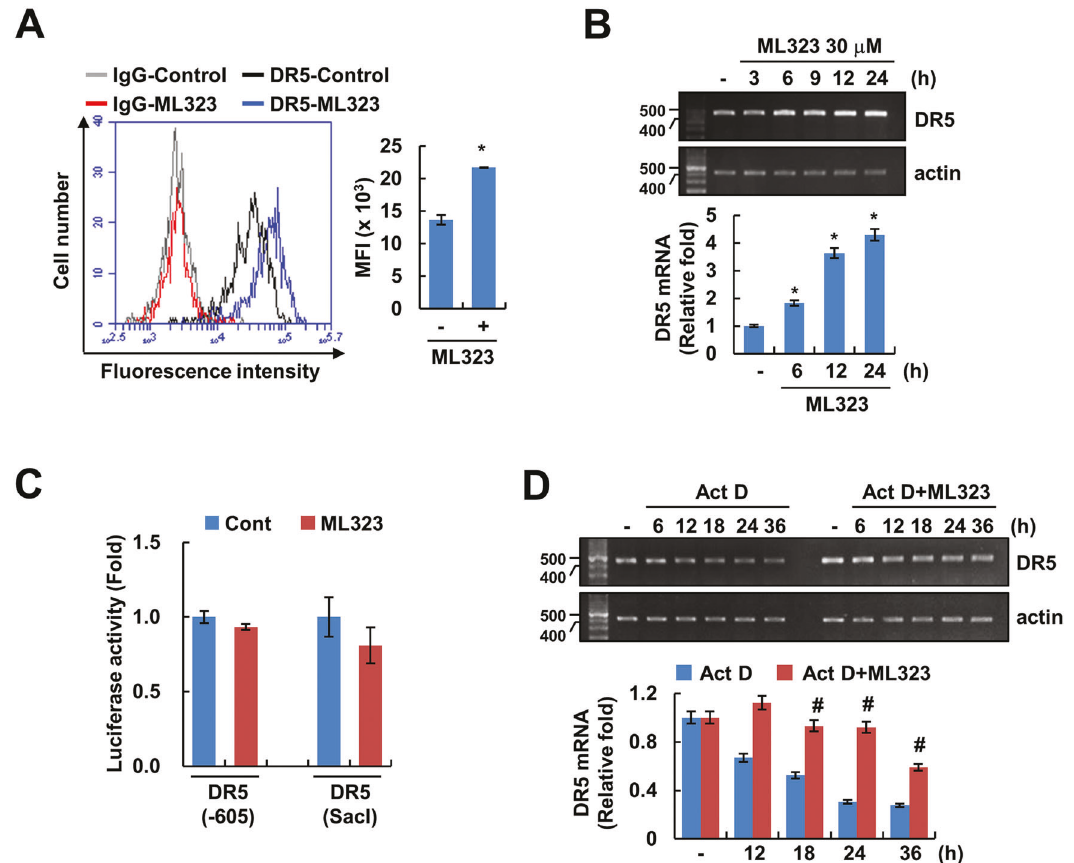
Fig. 3 ML323 upregulates DR5 expression at the post-transcription level. A Investigation of DR5 surface expression in Caki-1 cells treated to 30 μ M ML323 for 12 h. B Investigation of DR5 mRNA expression using RT-PCR and qPCR in Caki-1 cells treated to 30 μ M ML323 for the indicated time periods. C Caki-1 cells were transiently transfected with DR5 ( − 605) or DR5 (SacI) promoter plasmids, treated with 30 μ M ML323 for 12 h, and analyzed by luciferase activity assay. D Caki-1 cells were pretreated with 2 μ g/mL actinomycin D (Act D) for 30 min and then treated with 30 μ M ML323 for the indicated time periods. DR5 mRNA expression were analyzed using RT-PCR and qPCR. Values in the graphs ( A – D ) represent the mean ± SD of three independent experiments. * P < 0.01 compared to the control. # P < 0.01 compared to Act tissues. The expression levels of USP1 was higher in tumor tissues Mouse xenograft model Male BALB nude mice (Bagg and albino) were purchased from JA Bio, Inc. than in non-tumor tissues (Fig. 1A). To determine the overall (Suwon, Korea). HCT116 cells were subcutaneously injected into the fl ank survival rate, prognostic relevance of USP1 was analyzed by of each mouse. Mice were randomized into two groups (six mice per correlating baseline USP1 expression with the overall survival of group) for treatment with either vehicle [2% dimethyl sulfoxide (DMSO)/ RCC. Patients with high-expression levels of USP1 had shorter PBS] or 10 mg/kg ML323 three times a week, an intraperitoneal injection. overall survival time than those with low expression levels in TCGA Tumor size was calculated using the formula [(length × width 2 )/2]. To dataset ( P = 0.00388) and TARGET dataset ( P = 0.043) (Fig. 1B). We prove apoptosis in vivo sample, we performed Terminal deoxynucleotidyl performed the univariate and multivariate analyses in 418 RCC patients. Univariate analysis showed that age ( p = 0.006), stage ( p < 0.001), and smoking ( p = 0.002) correlate with overall survival of RCC patients. In multivariate analysis, smoking and stage ( p < 0.001) were related to RCC patient survival (Supplementary Table. S1). To investigate whether the differential expression pattern of apoptosis-related proteins caused USP1 inhibition, we explored the changes in apoptosis-associated proteins induced by USP1 speci fi c inhibitors (ML323 and pimozide) in Caki-1 cells. Signi fi cant differences in the expression of these two proteins were detected after treatment with USP1 inhibitors. DR5 expres- sion levels were increased after 24 h in the two USP1 inhibitor treatments, whereas survivin expression was downregulated. However, the expression of other proteins (Bcl-2 and IAP family proteins, DR4, and c-FLIP) was not changed by the two USP1 inhibitors (Fig. 1C). Next, we investigated the effect of ML323 on diverse cancer cell lines (renal carcinoma, ACHN; lung carcinoma, A549; colon carcinoma, HCT116; and hepatocellular carcinoma, SK- Hep1). ML323 induced a similar expression pattern in all tested